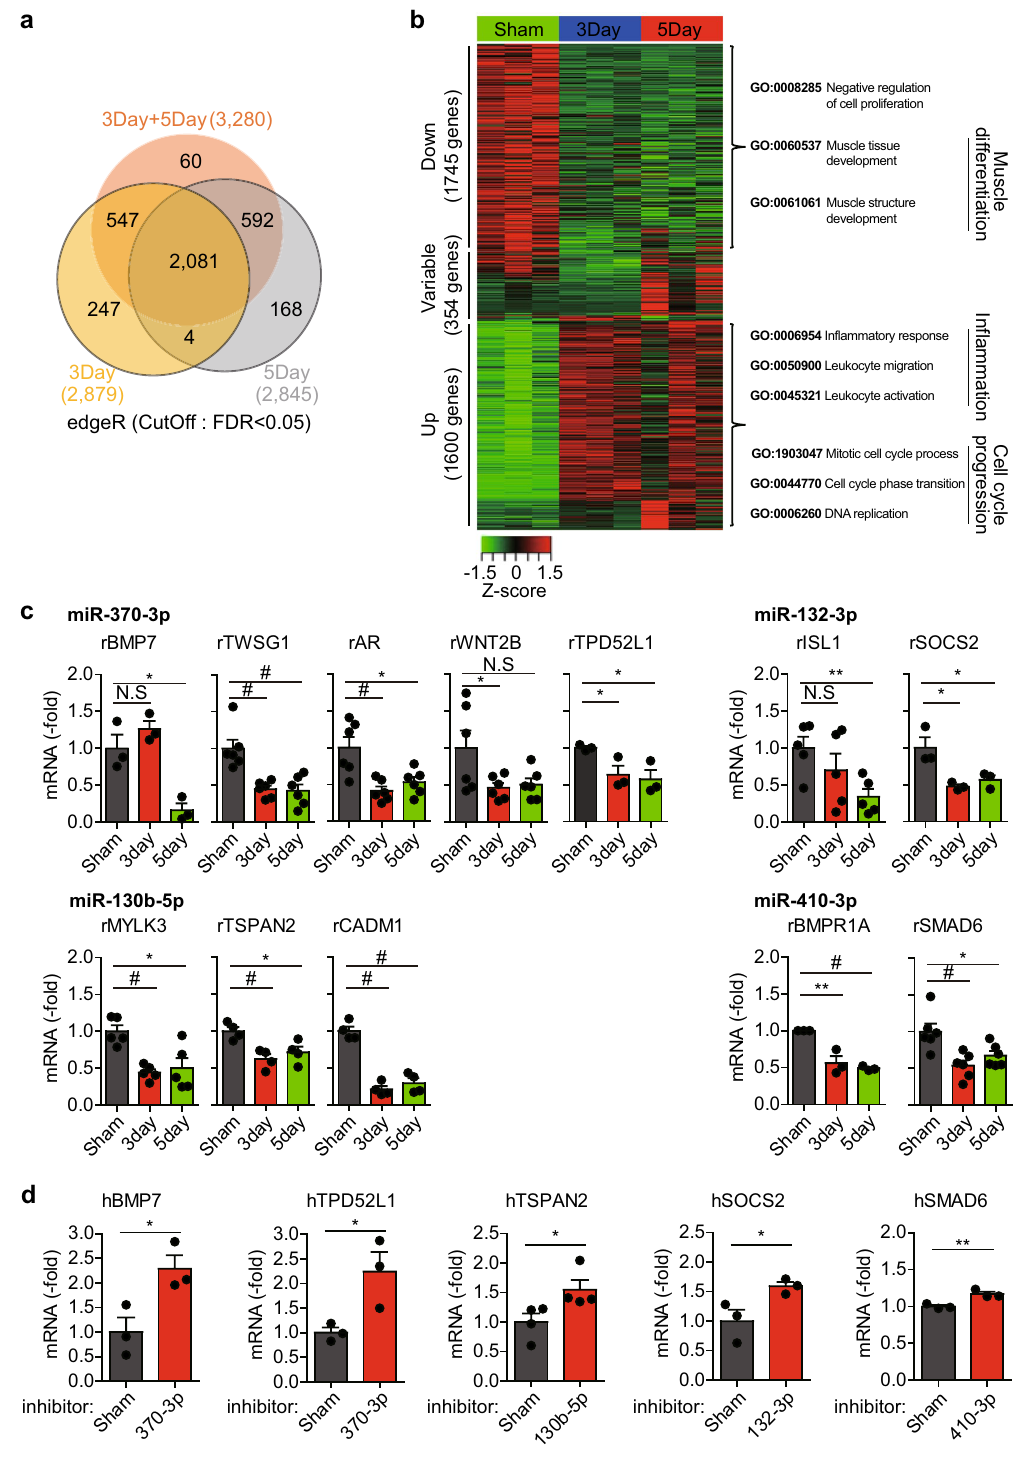
Figure 4. Identification of target genes specific to the selected miRNAs. ( a ) Venn diagram depicting the number of differentially-expressed genes (DEGs) overlapped between the recovery times post injury ( n = 3, Cutoff: FDR < 0.05). ( b ) Heatmap depicting the relative expressions and correlations of the 3699 DEGs. ( c ) Expression of the miRNA target genes in the injured rat carotid arteries. Data in the graphs are means ± SEM of fold changes compared to sham control ( n = 3–6, * P < 0.05, ** P < 0.01, # P < 0.005). ( d ) Expression of the miRNA target genes in the HASMC transfected with the indicated miRNA inhibitors. Data in the graphs are means ± SEM of fold changes compared to non-specific control (N.C) ( n = 3–4, * P < 0.05, ** P <